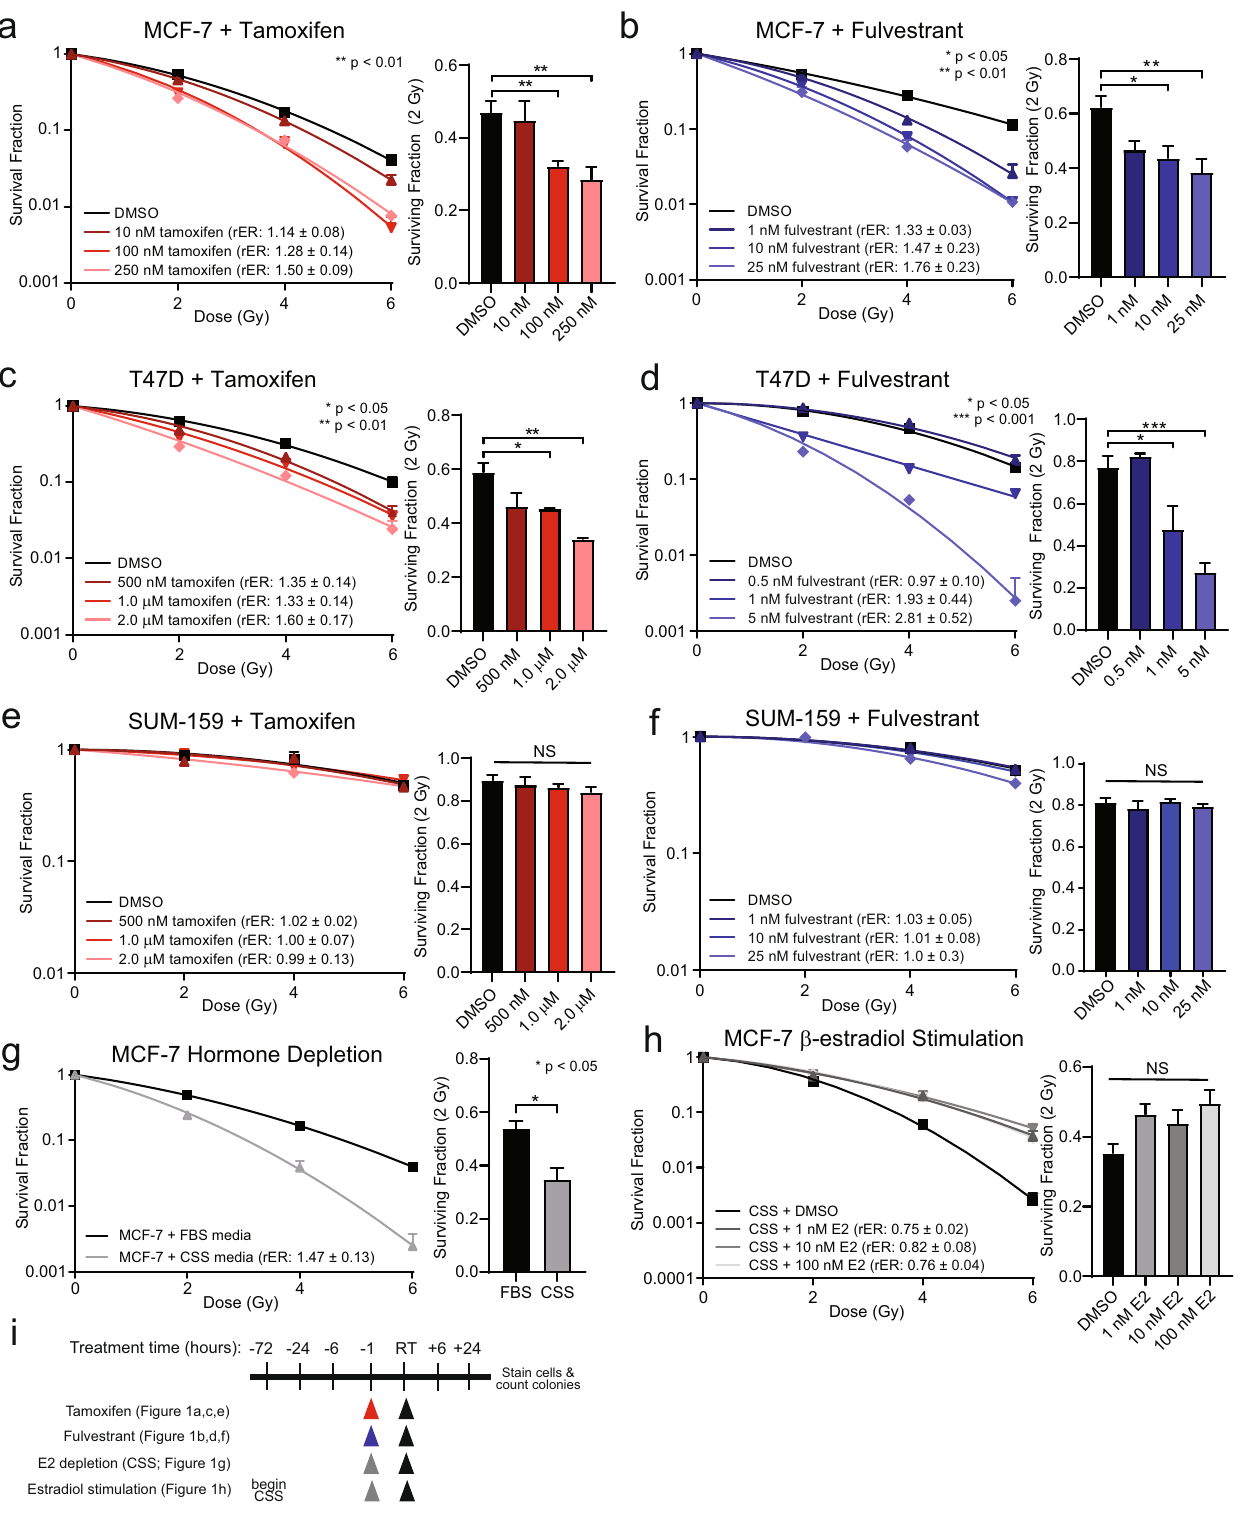
Fig. 1 Radiosensitization of ER + breast cancer cell lines with anti-estrogen therapies. Clonogenic survival assays indicate concentration- dependent radiosensitization of ER + MCF-7 cells with tamoxifen ( a ) or fulvestrant ( b ). Radiosensitization was also observed in T47D cells with tamoxifen ( c ) or fulvestrant ( d ) treatment, but not in the ER-negative SUM-159 cells treated with tamoxifen ( e ) or fulvestrant ( f ). Clonogenic survival assays were performed in MCF-7 cells pretreated with CSS for 1 h compared to FBS-treated cells ( g ), or MCF-7 cells pretreated for 3 days with CSS before stimulation with β -estradiol ( h ). Clonogenic treatment times are displayed in a schematic ( i ). Data from three or four replicate experiments are graphed as mean ± SEM. (* P < 0.05; ** P < 0.01; *** P < 0.001; NS = not signi fi